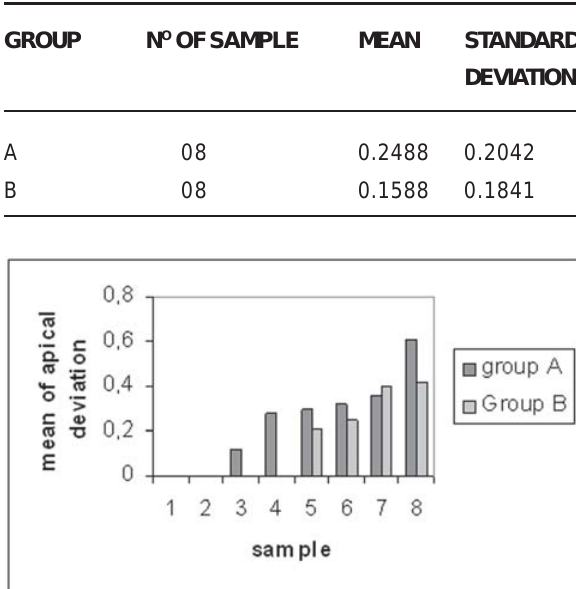
TABLE 1- Descriptive analyses of experimental group